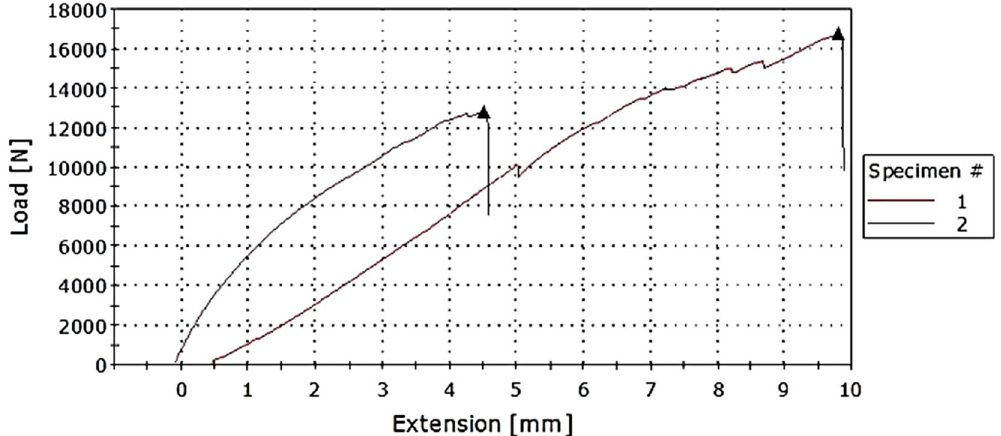
Figure 1. Tensile strength against treated (1) and untreated (2) composites.